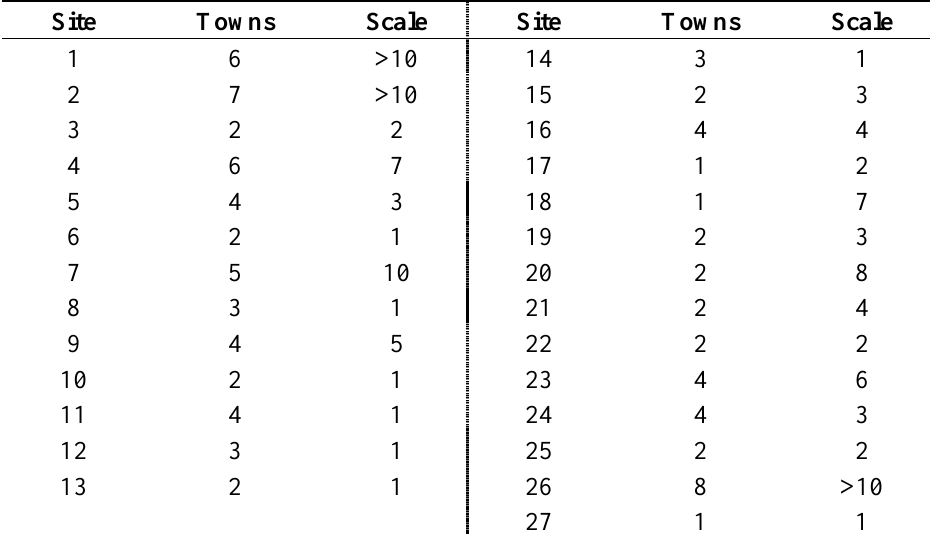
Table 3. The number of scales and towns be covered for 27 monitoring